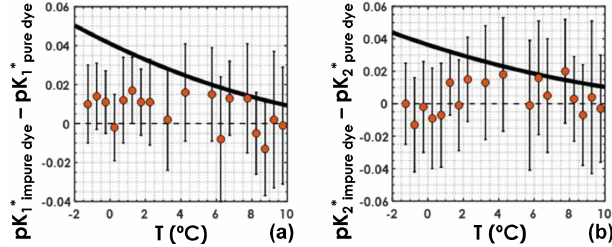
Figure 4. (a) pK ∗ and (b) pK ∗ differences between those obtained 1 2 with the regular dataset and those obtained with the purified-dye independent dataset, as a function of in situ seawater temperature. Orange circles represent the mean computed pK ∗ values within a temperature bin, and the vertical black bars stand for the associated uncertainties deviations. The solid black line is the difference be- tween the pK ∗ fit from this study and that from Lueker et al.